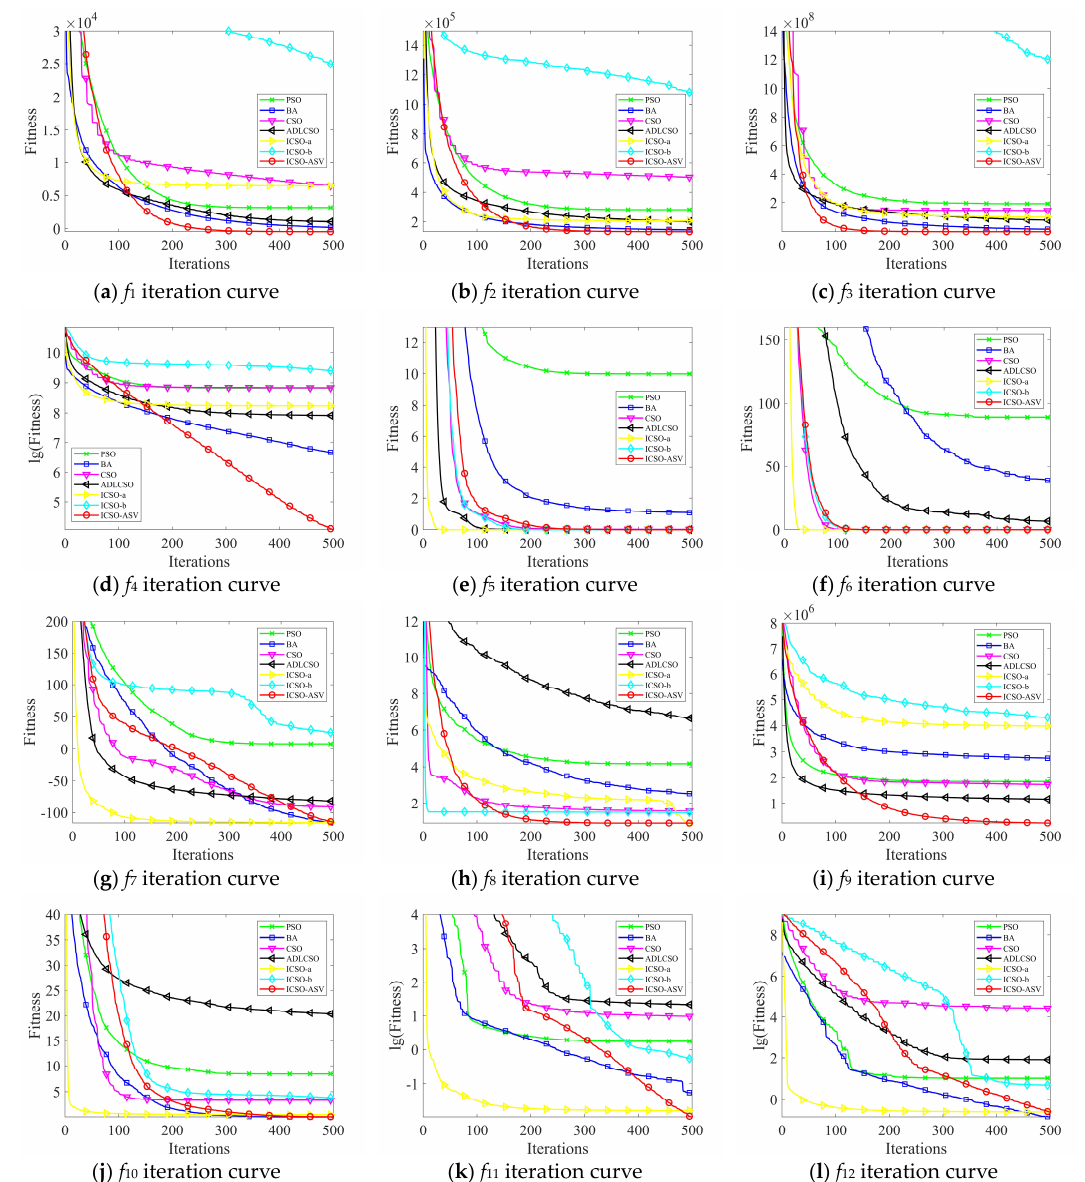
Figure 2. Iteration curves of the 50D benchmark test functions.